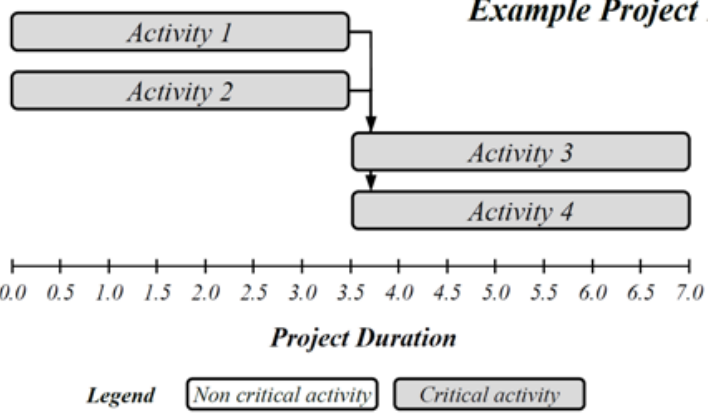
Figure 1. Gantt chart with Critical Path representation of example project 1